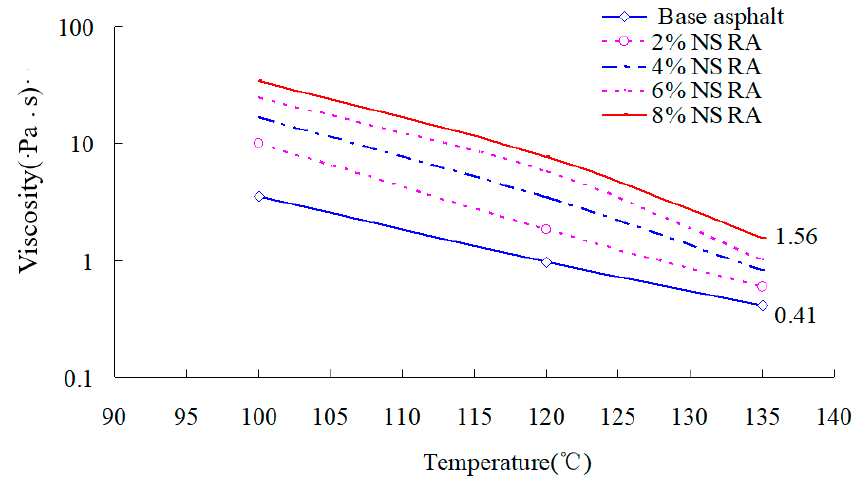
Figure 3. Viscosity of the NS RA-modified asphalt.